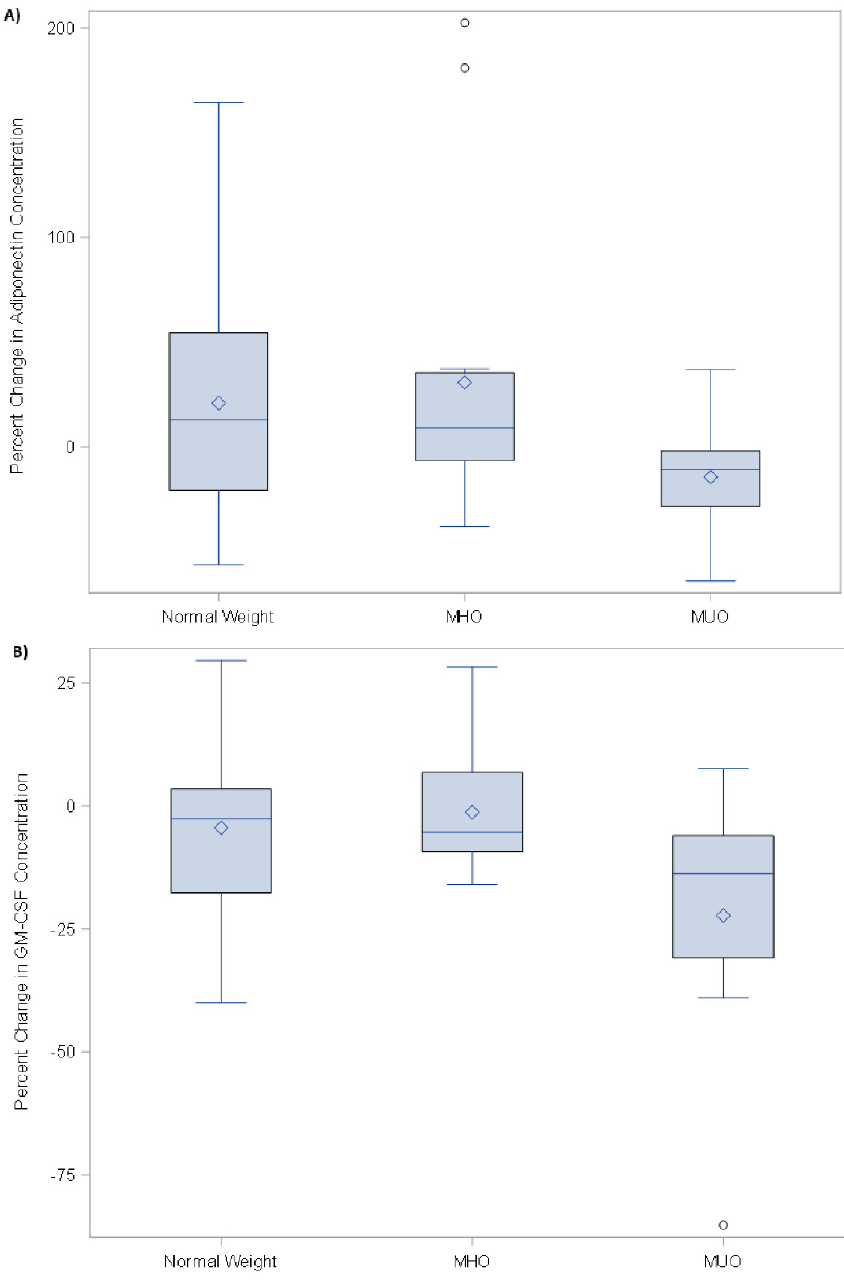
Figure 3. IL-10 percent change in concentration from baseline to 1 month post-influenza vaccination.